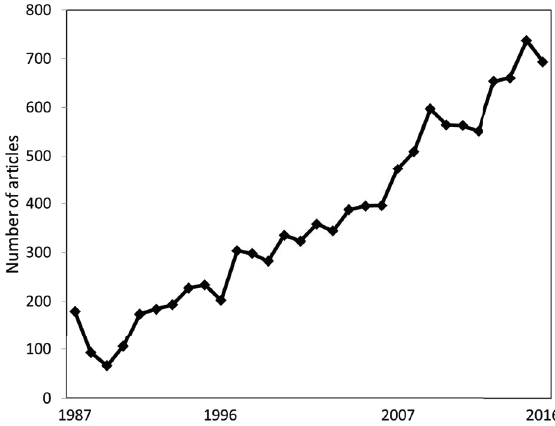
Figure 1 - Number of articles published on the deep sea between 1987 and 2016 from data available from the Web of